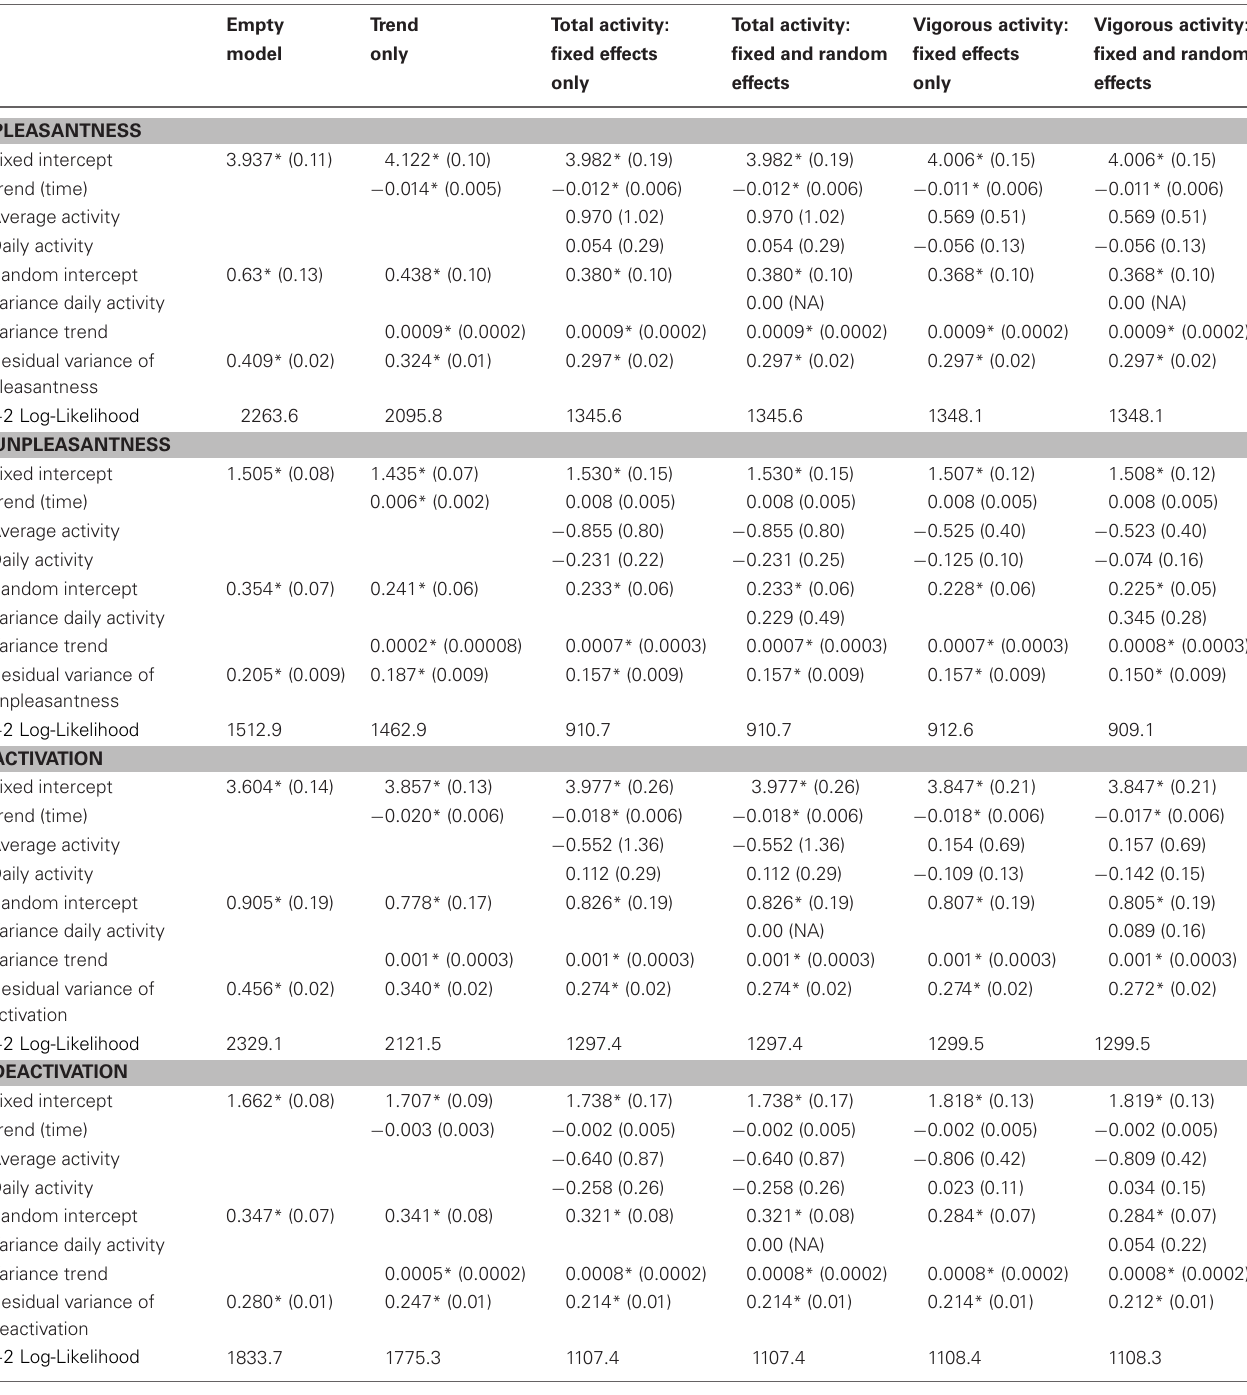
Table 3 | Parameter estimates of the described models (standard errors in parentheses). Empty Trend Total